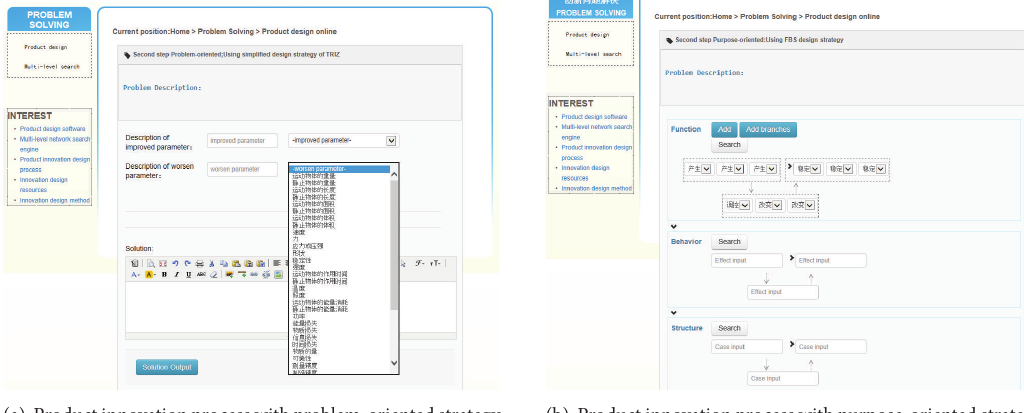
Figure 8: Interface of product innovation process with different strategies.